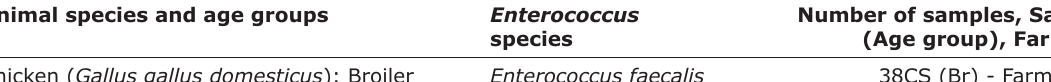
Number of samples, Sample type, species (Age group), Farm